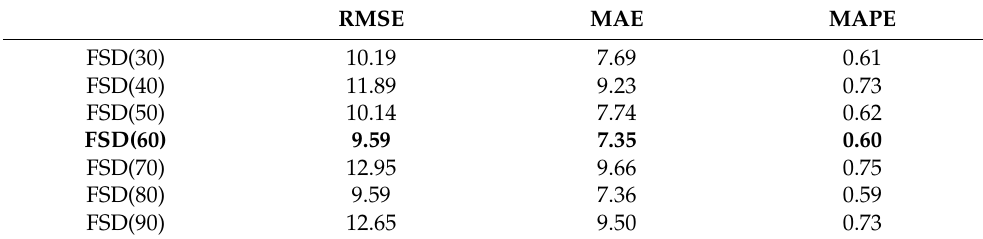
Table 4. Three-year forecasting performance obtained by various FSDs.